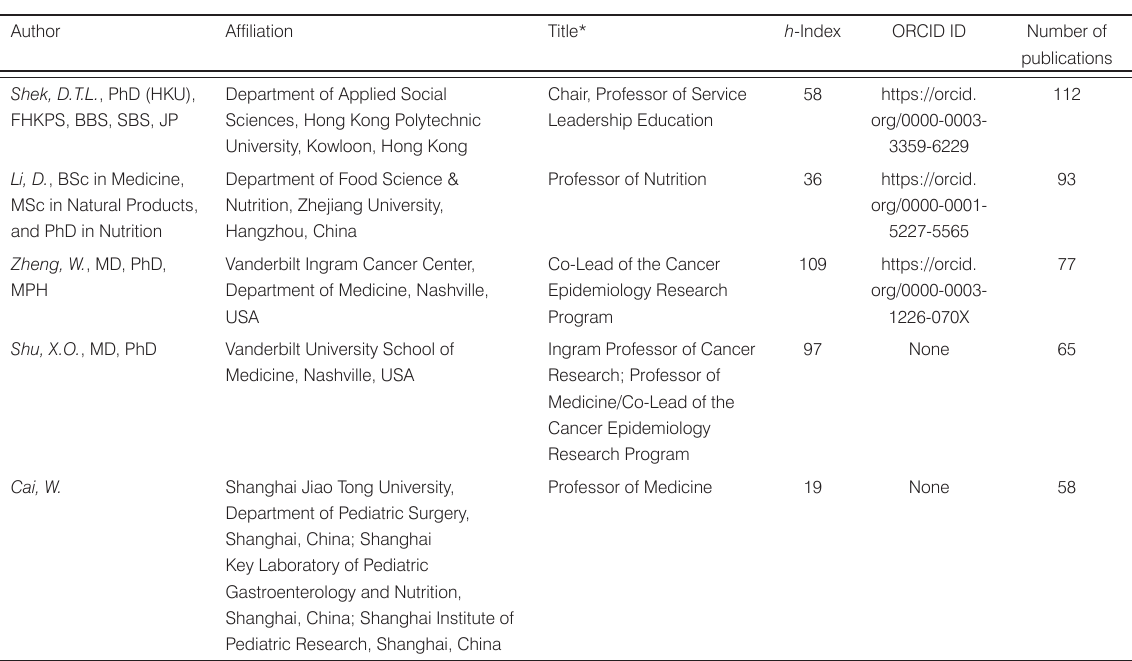
Table 4. Top five authors from China (those who published most frequently) in the category of “nursing” cited in Scopus in August